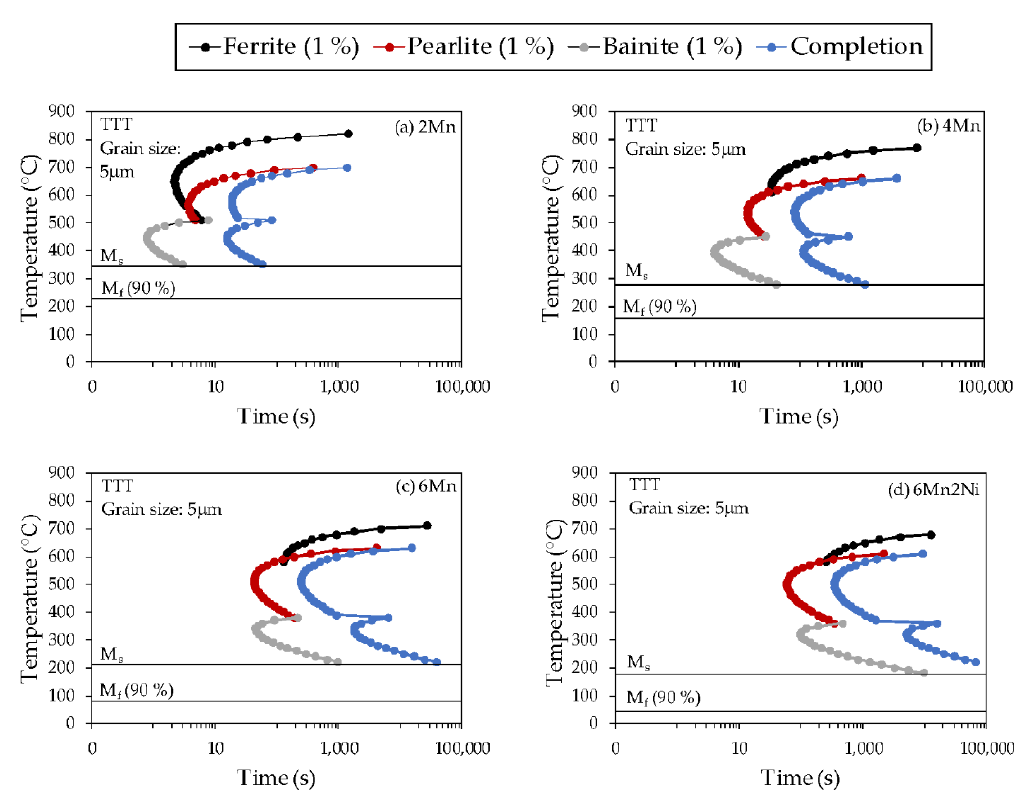
Figure 7. Time-temperature-transformation (TTT) diagrams calculated by JMatPro for an initial austenite grain size of 5 µm in alloys ( a ) 2Mn; ( b ) 4Mn; ( c ) 6Mn; ( d ) 6Mn2Ni.